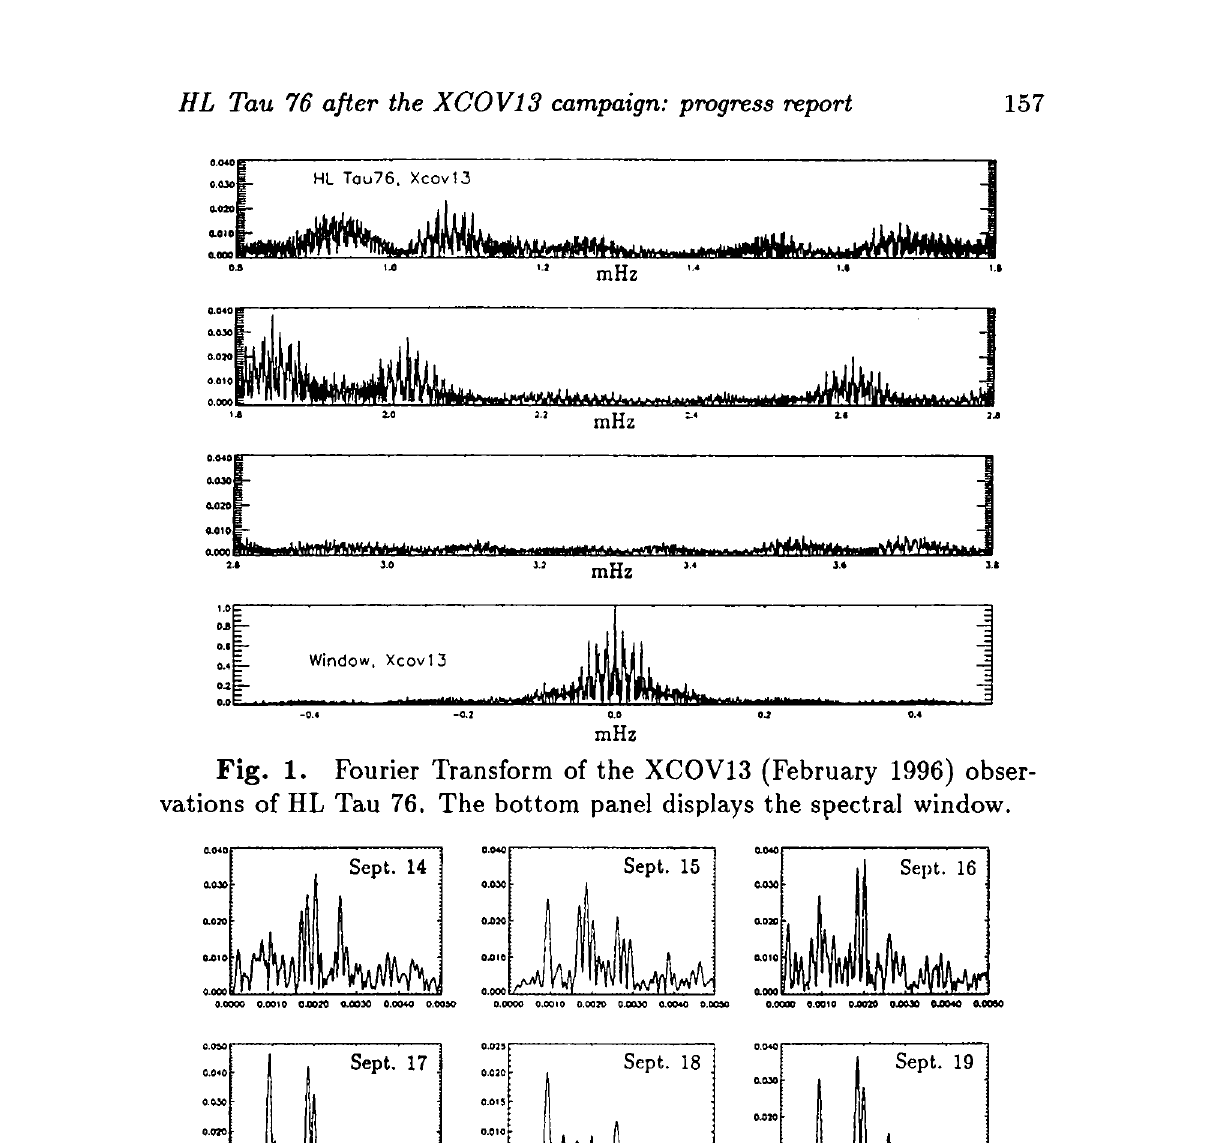
Fig, 2. Fourier Transform of individual nights of observations of HL Tau 76 (September